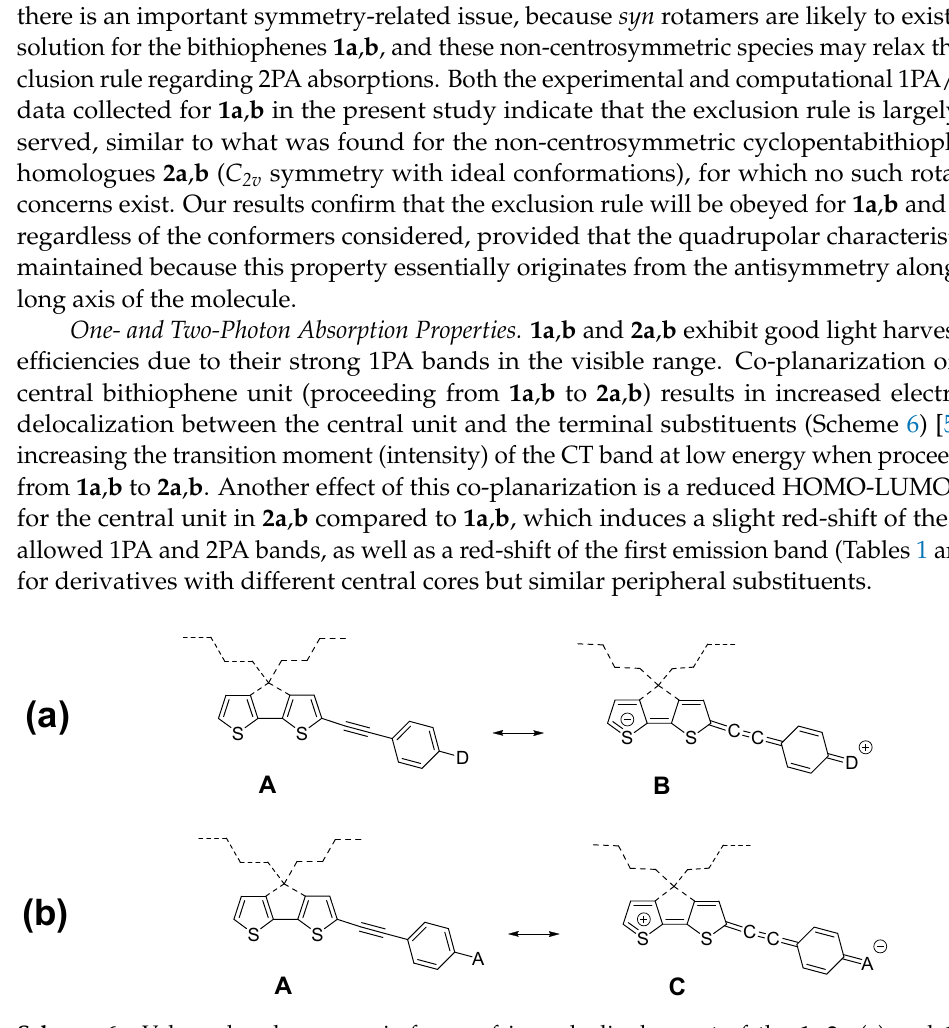
Scheme 6. Valence-bond mesomeric forms of in each dipolar part of the 1a , 2a ( a ) and 1b , 2b quadrupoles ( b ). The weight of the polar forms B and C is respectively larger in 2a , b than in 1a , b due to planarization of the π